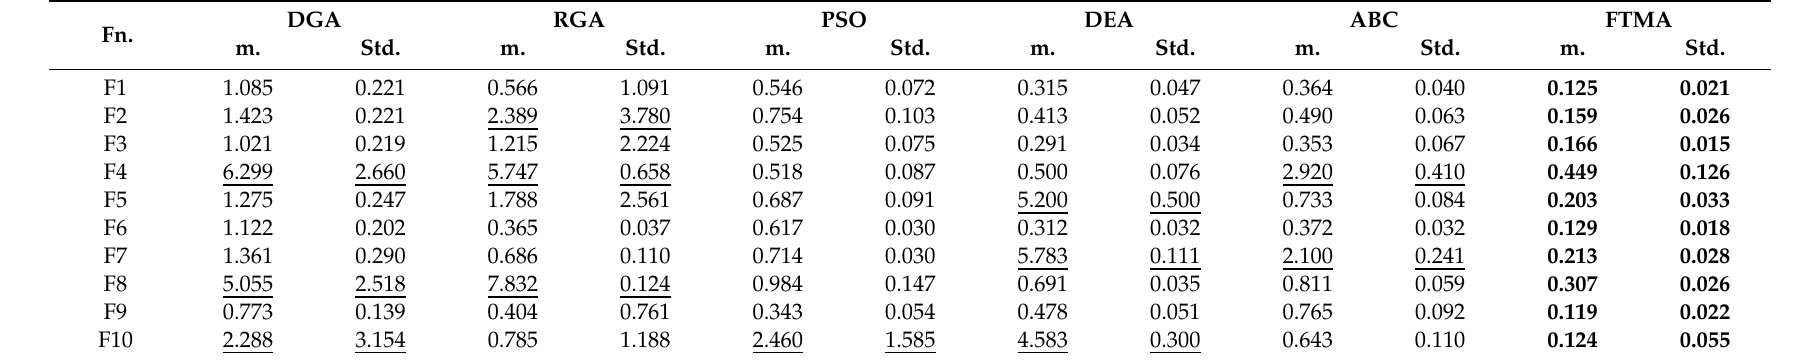
Table 5. Statistical results of the computation time (seconds) for 30